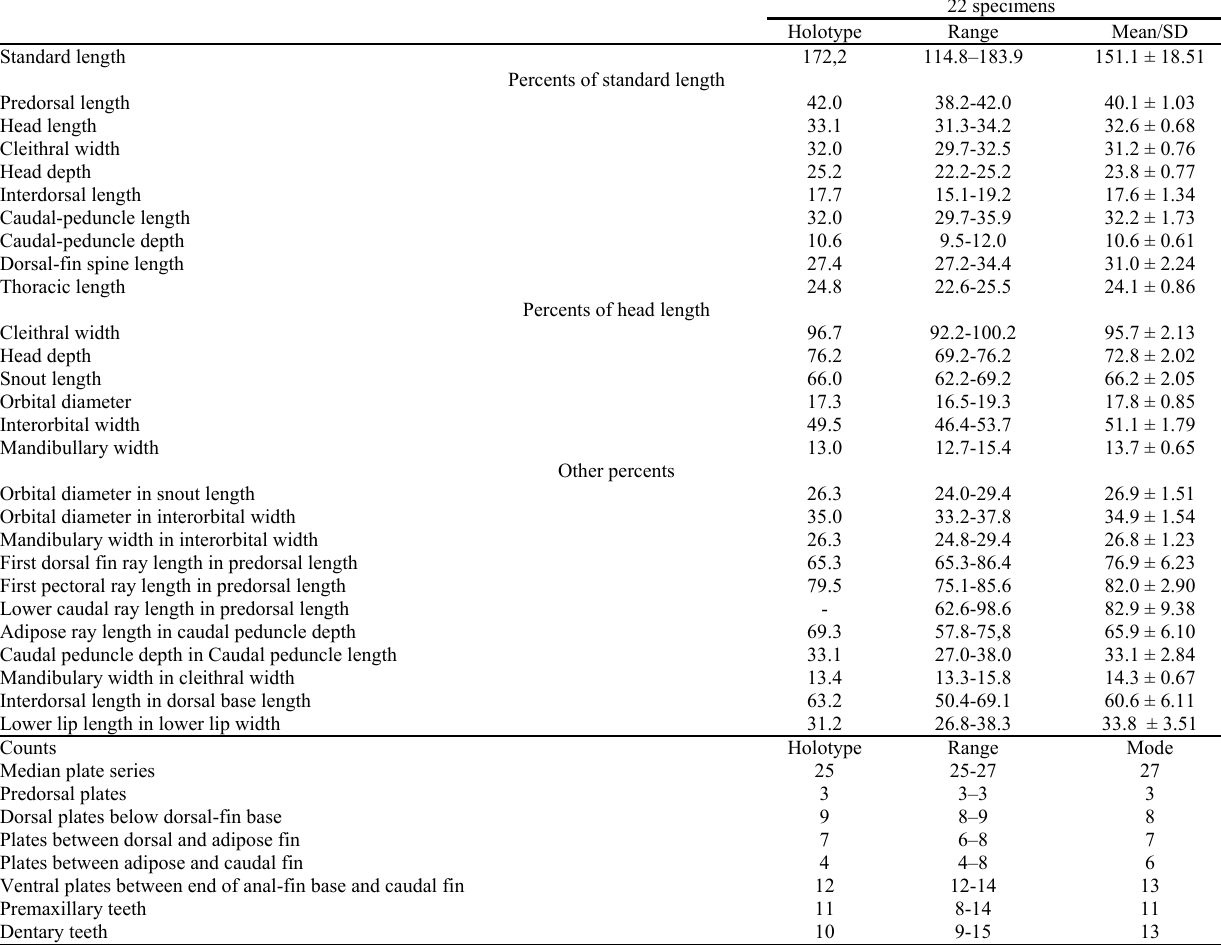
Table 1. Morphometric data and counts of Hypostomus